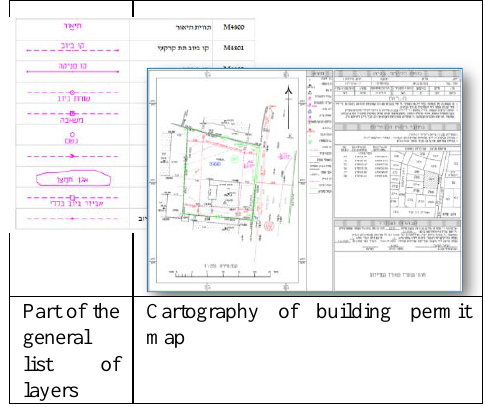
Figure 2: Excerpt from the national mapping standard